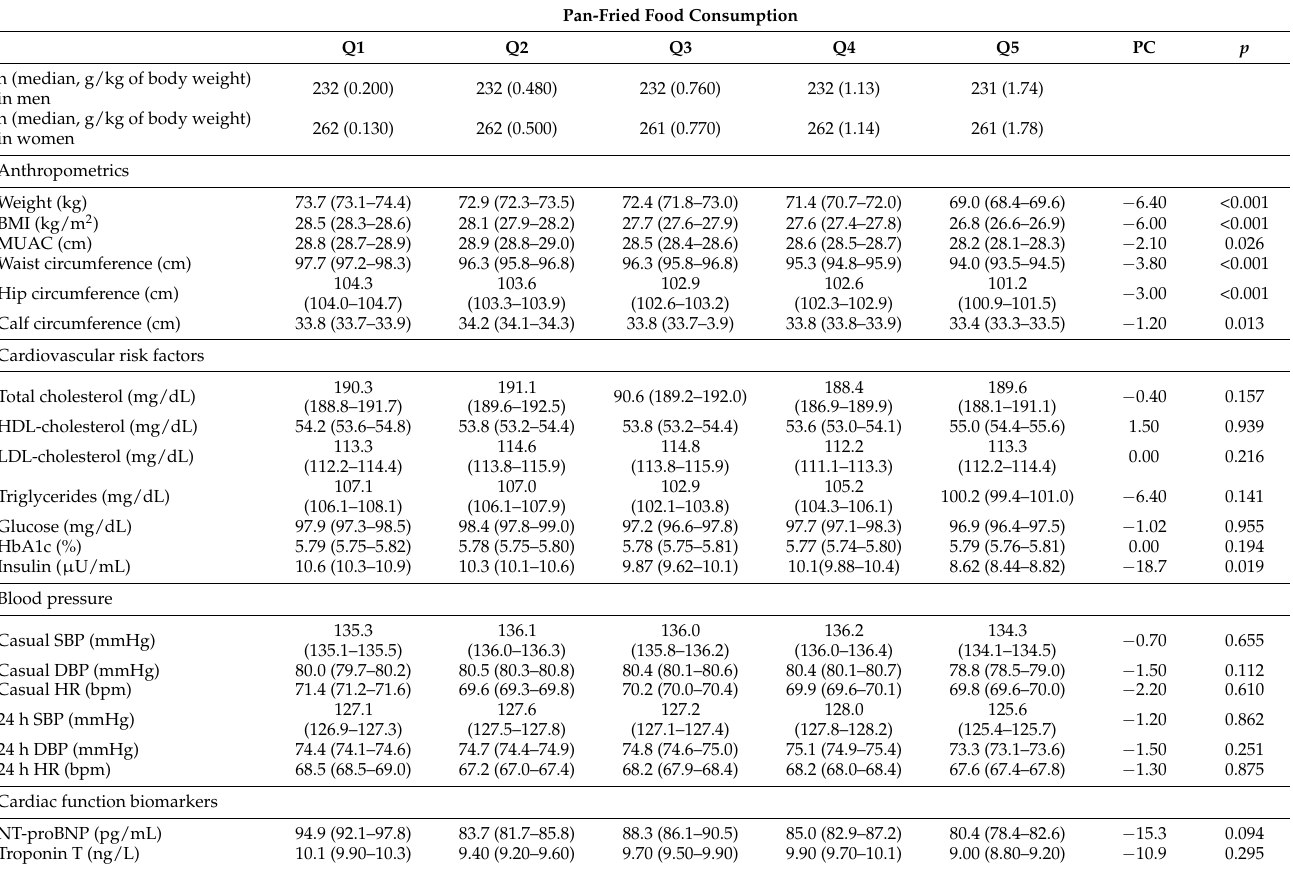
Table 5. Adjusted means (95% confidence interval), percentage difference, and p for a linear trend across quintiles of pan-fried food